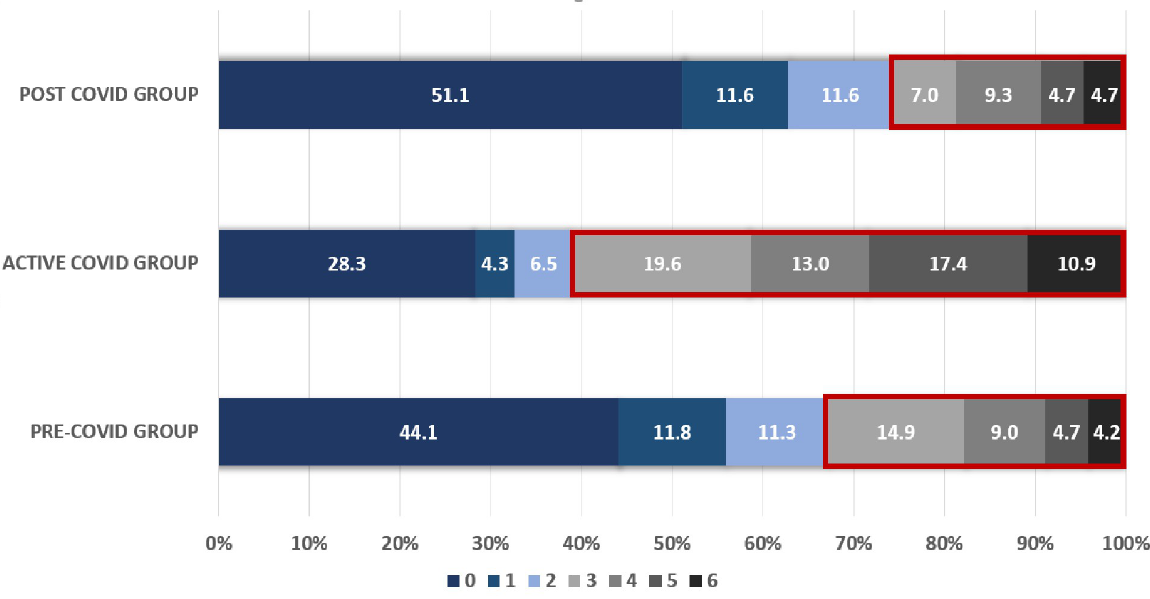
Fig 1. Showing outcome of patients with active COVID-19 infection have significantly fewer patients who improved to a mRS of 0–2 at the 90-days follow-up compared to patients who never had the viral infection or who fully recovered from the infection.